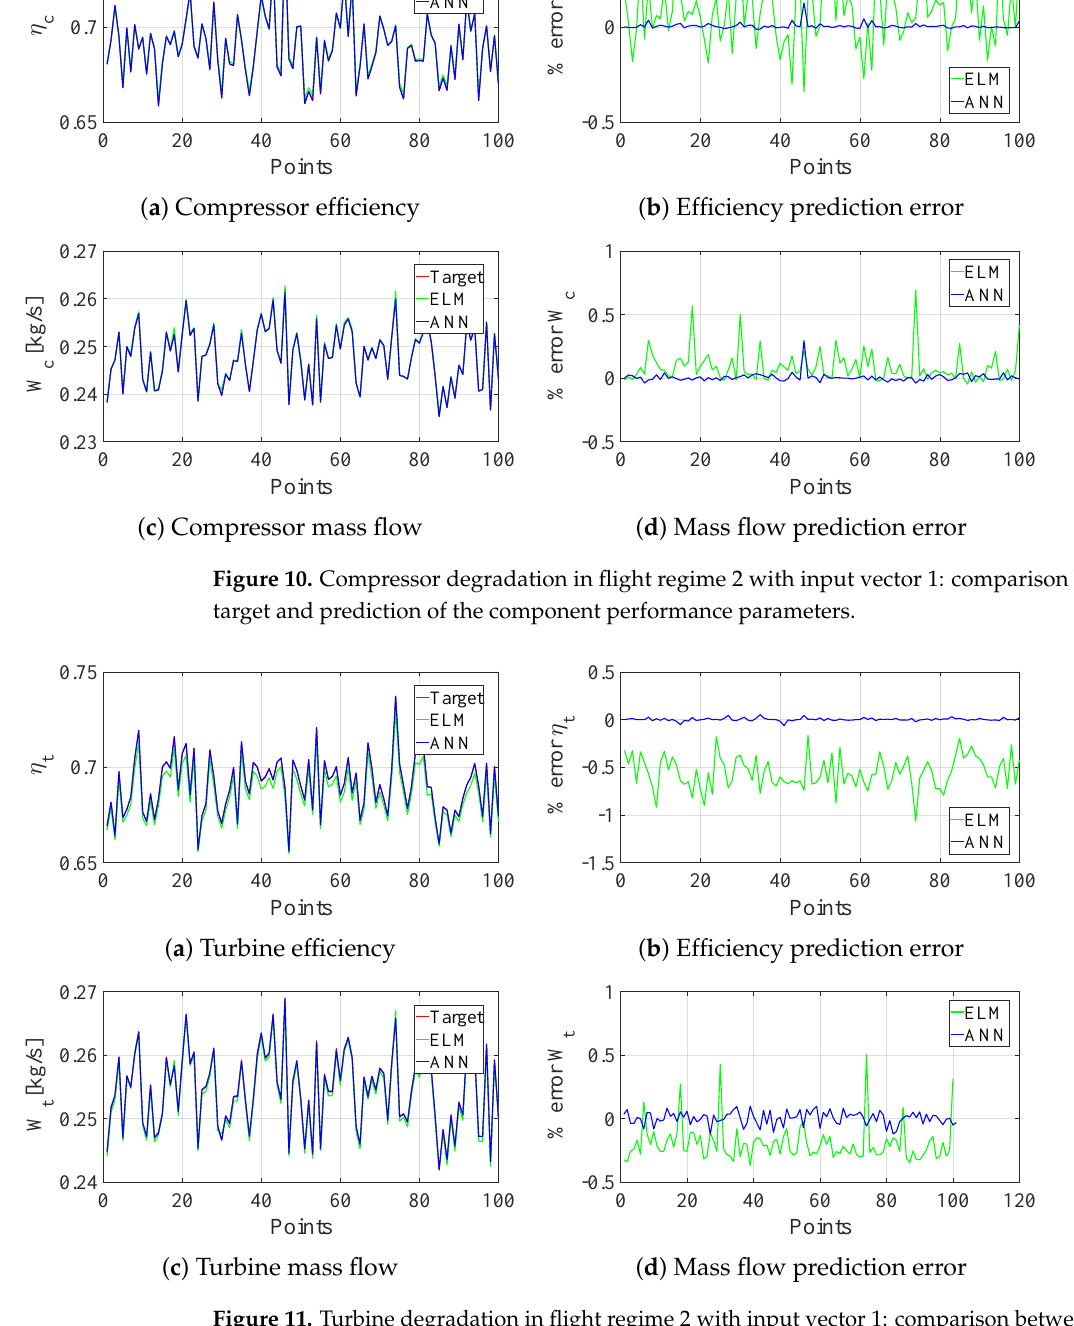
Figure 11. Turbine degradation in flight regime 2 with input vector 1: comparison between the target and prediction of the component performance